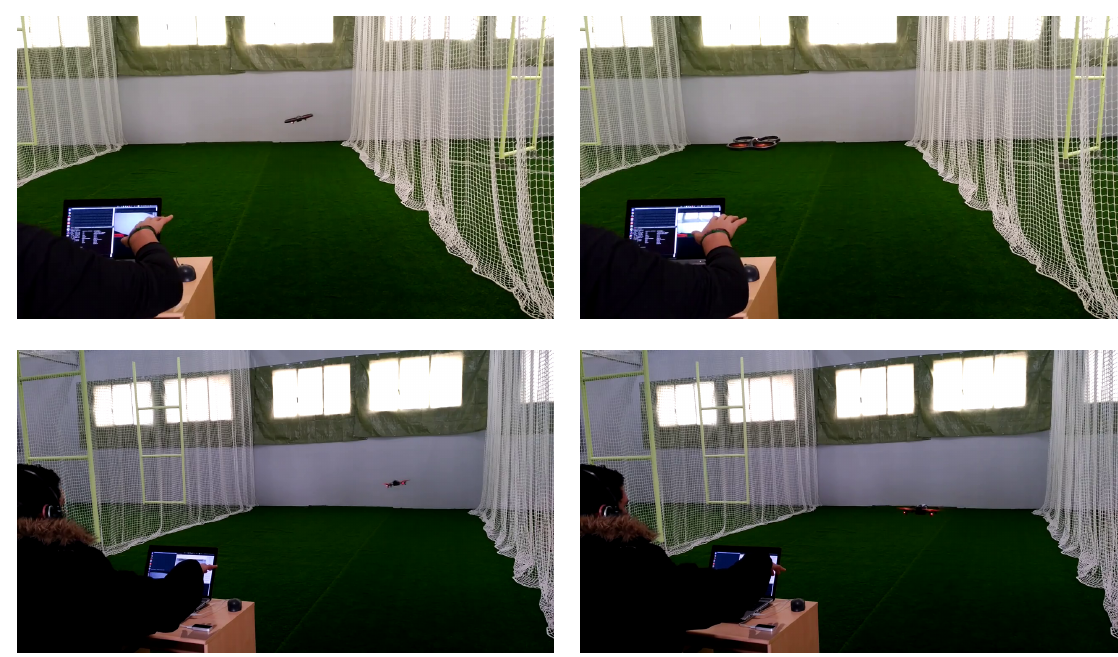
Figure 3. Four examples of human-drone interaction performed by hand gestures in